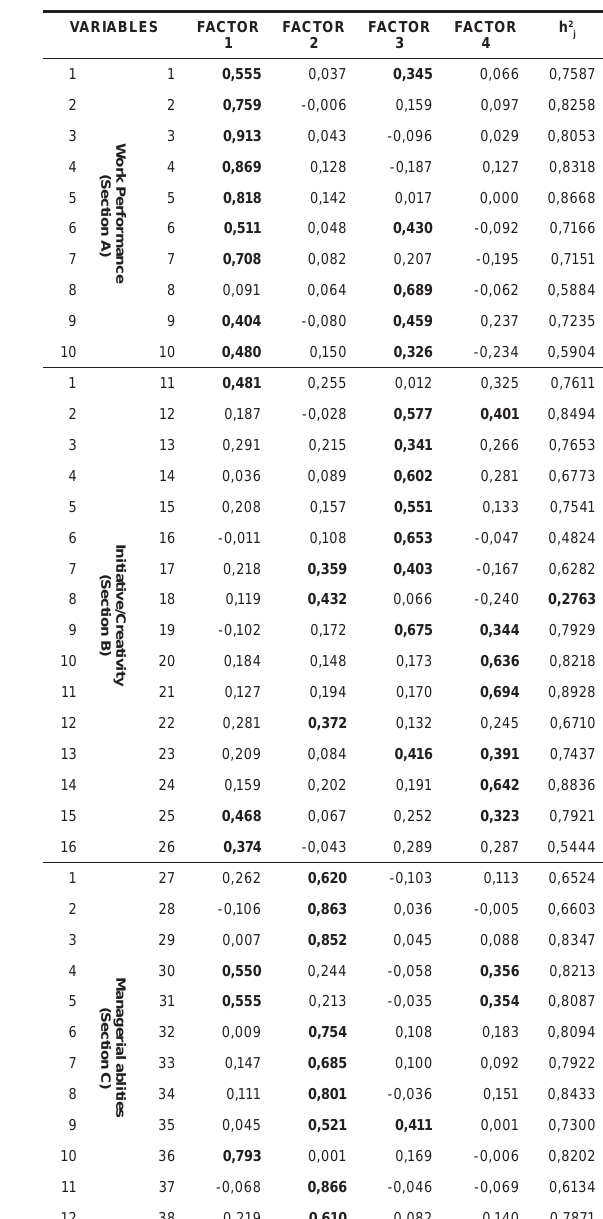
TAbLE 8 Rotated factor matrix (direct